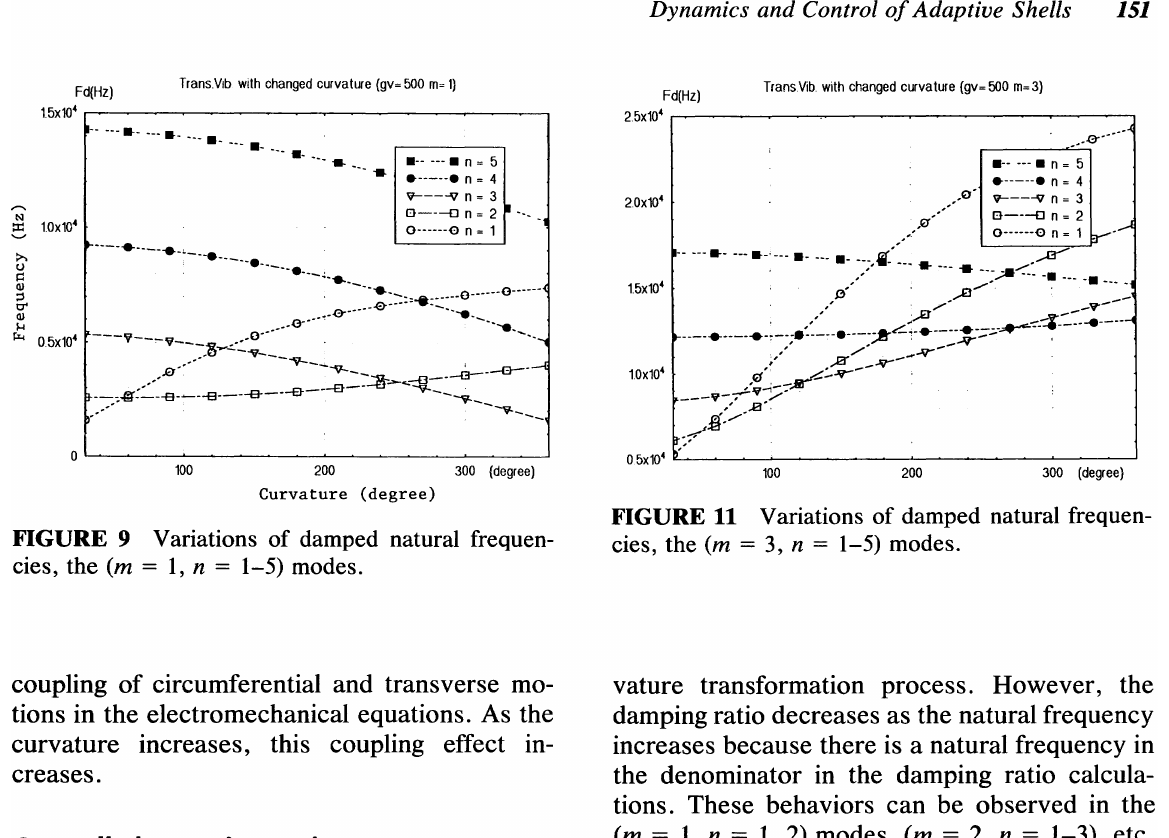
FIGURE 9 Variations of damped natural frequen cies, the (m = 1, n = 1-5) modes.